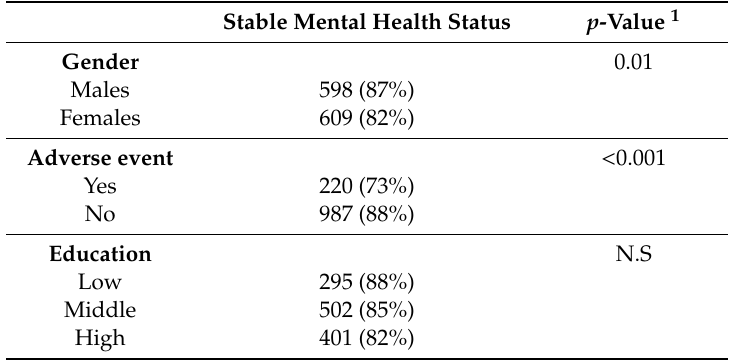
Table 2. Association between change in mental health and background characteristics.